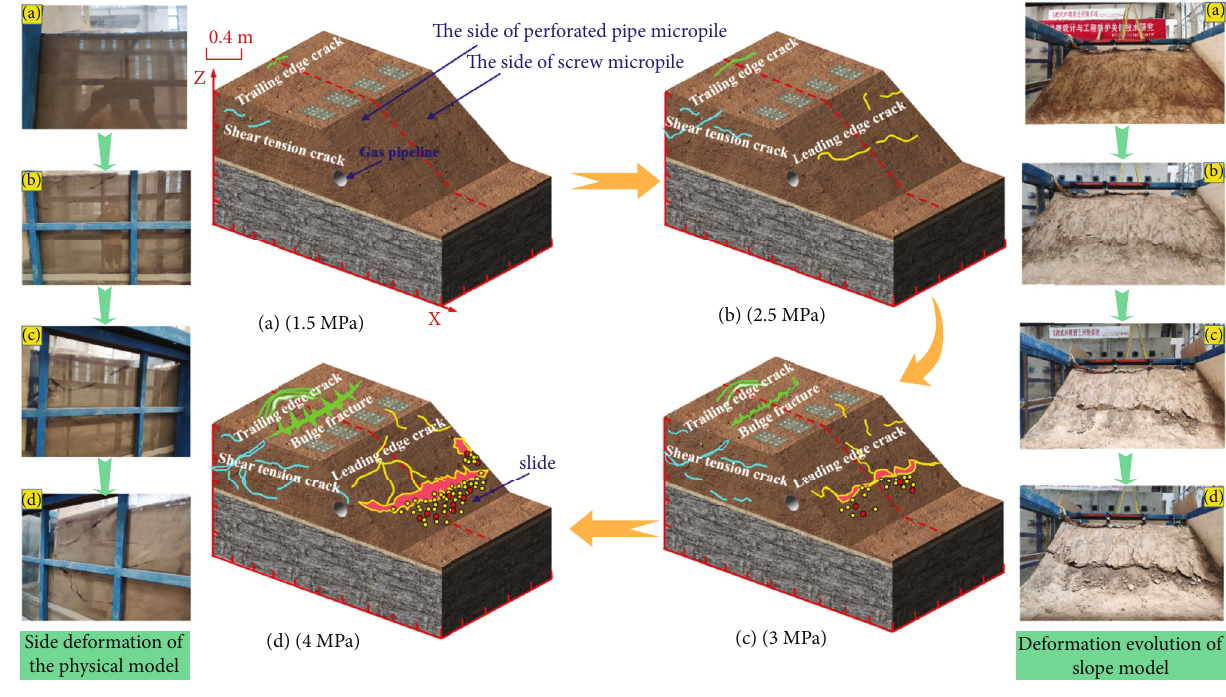
Figure 8: Apparent deformation evolution of landslide-pipeline system.